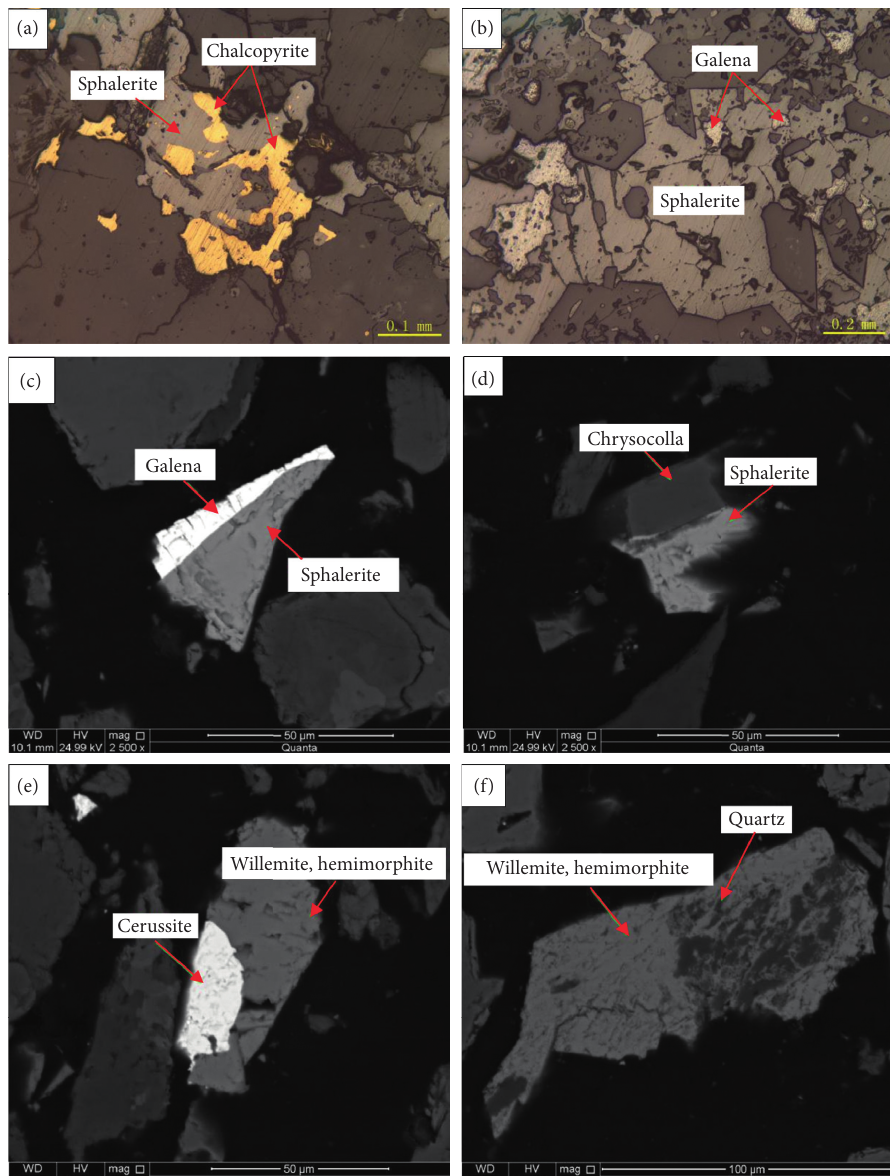
Figure 9: Embedded characteristics of sphalerite, willemite, and